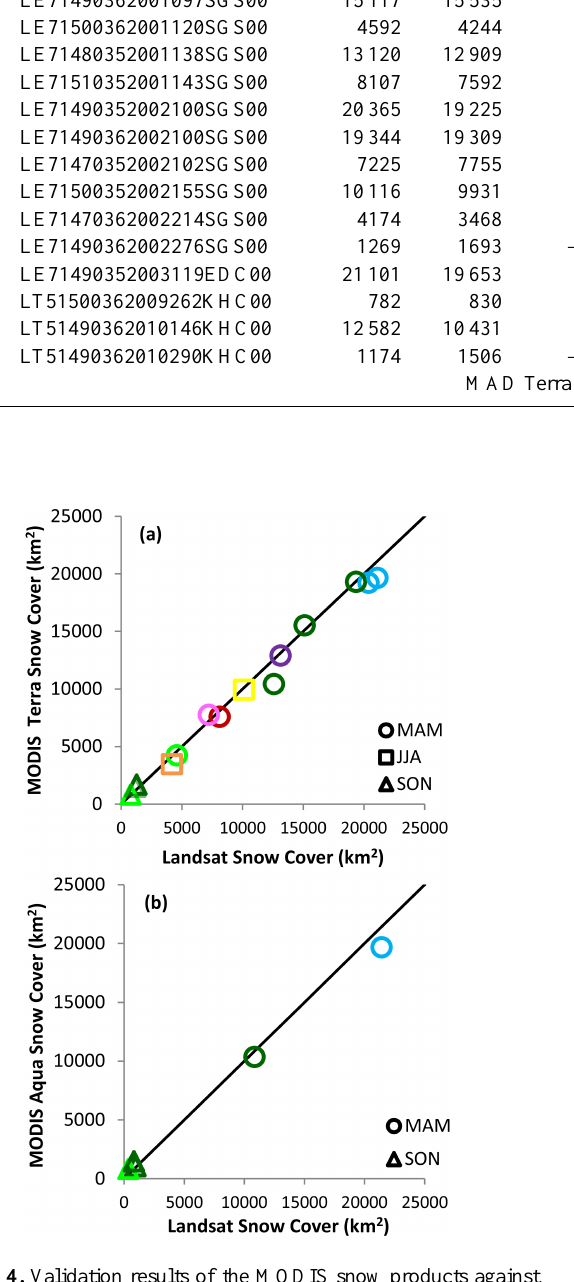
Figure 4. Validation results of the MODIS snow products against Landsat TM/ETM + images. (a) MODIS Terra product against Landsat scenes; (b) MODIS Aqua product against Landsat scenes. Note: each colour identifies a unique location (“Path” and “Row”) of the Landsat scene acquisition, while each different shape identi- fies a particular season.